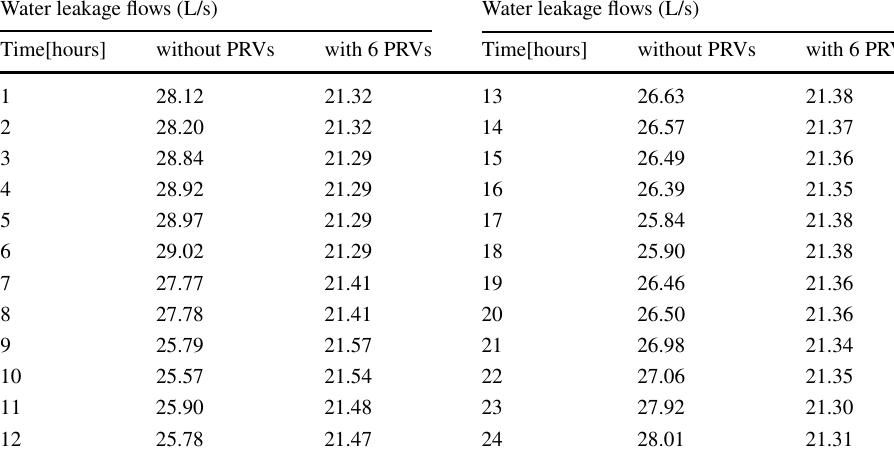
Table 3 Comparisons of water = 1.18 leakage flows with 𝛾